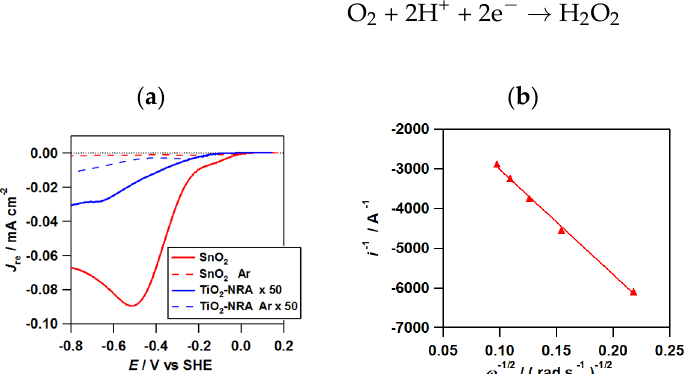
Figure 2. ( a ) Linear sweep voltammogram obtained with the TiO 2 /FTO and FTO electrodes in ar- gon gas-bubbled and aerated 0.1 M NaClO 4 electrolyte solution (pH 5.70) with a potential sweep rate of 20 mVs − 1 . J re expresses the current density per real surface area of the electrode. ( b ) Koutecky-Levich plots of the FTO electrode for the current as E = − 0.8 V.